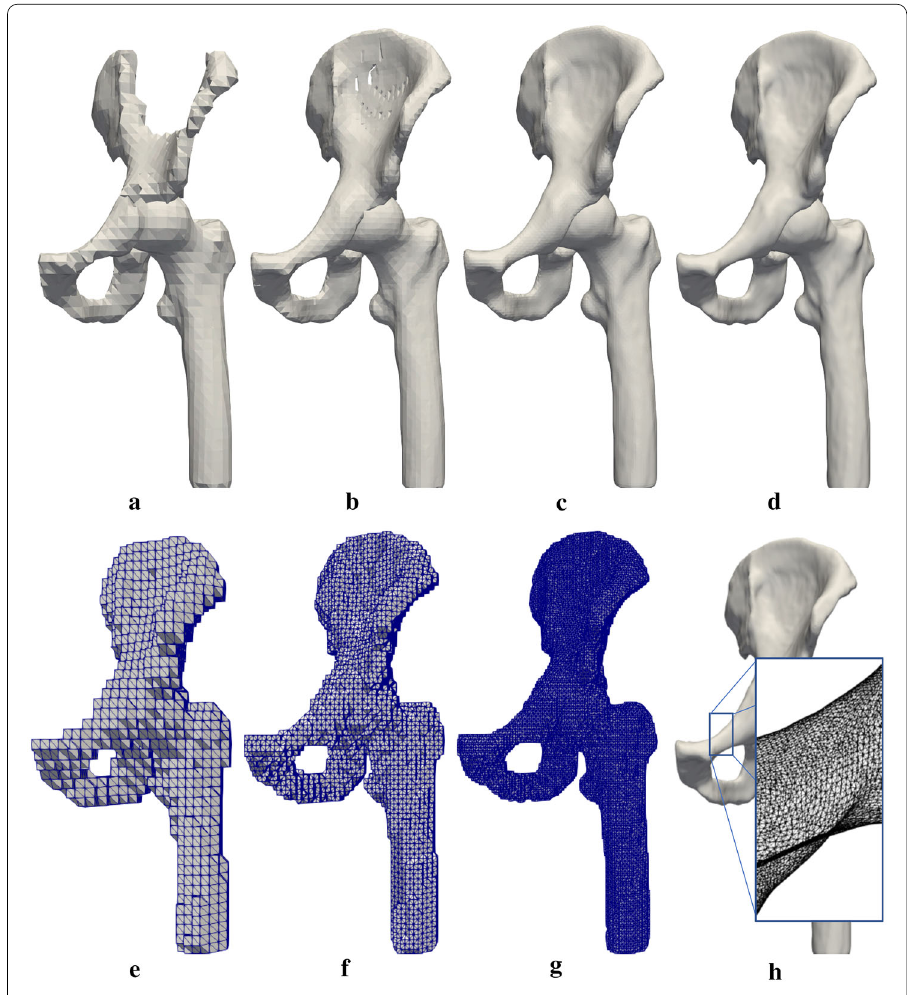
Fig. 5 Effect of background mesh size onto geometric approximation. The zero level set contour for 2 steps of refinement of all tetrahedrons which are colliding with the surface triangulation is shown in a – c